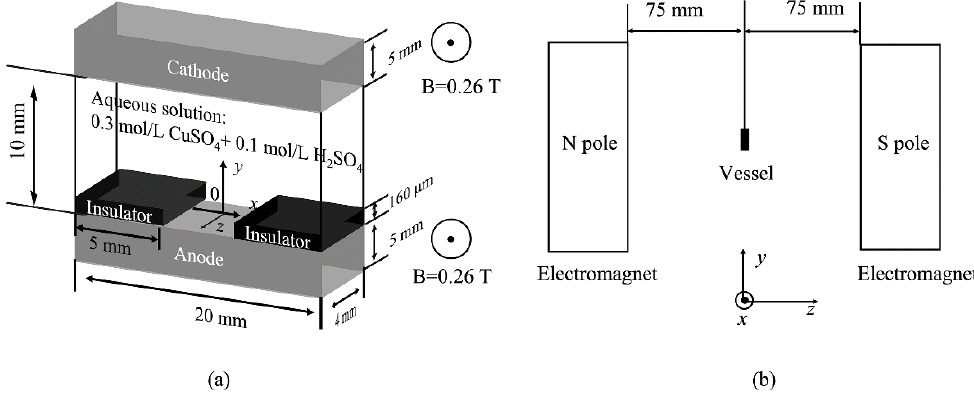
Figure 1. ( a ) Bird’s-eye view of experimental apparatus and ( b ) side view of relative position between the vessel and electromagnet.